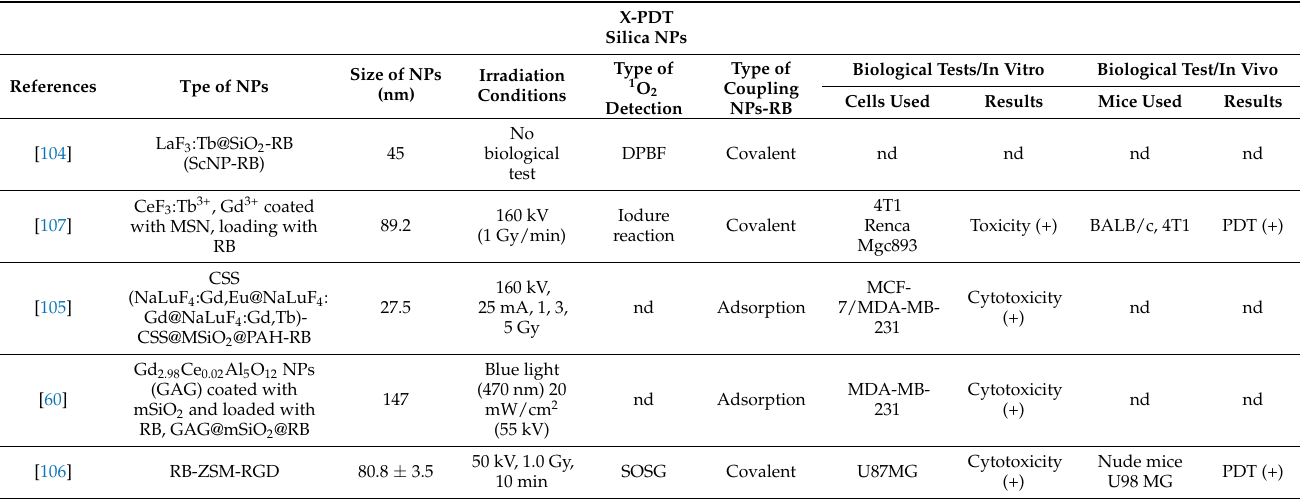
Table 7. References dealing with silica NPs@RB under X-rays, including the type of NPs, along with their size, excitation wavelength, type of detection of 1 O 2 , the type of coupling between the NPs and the RB, and the type of biological tests